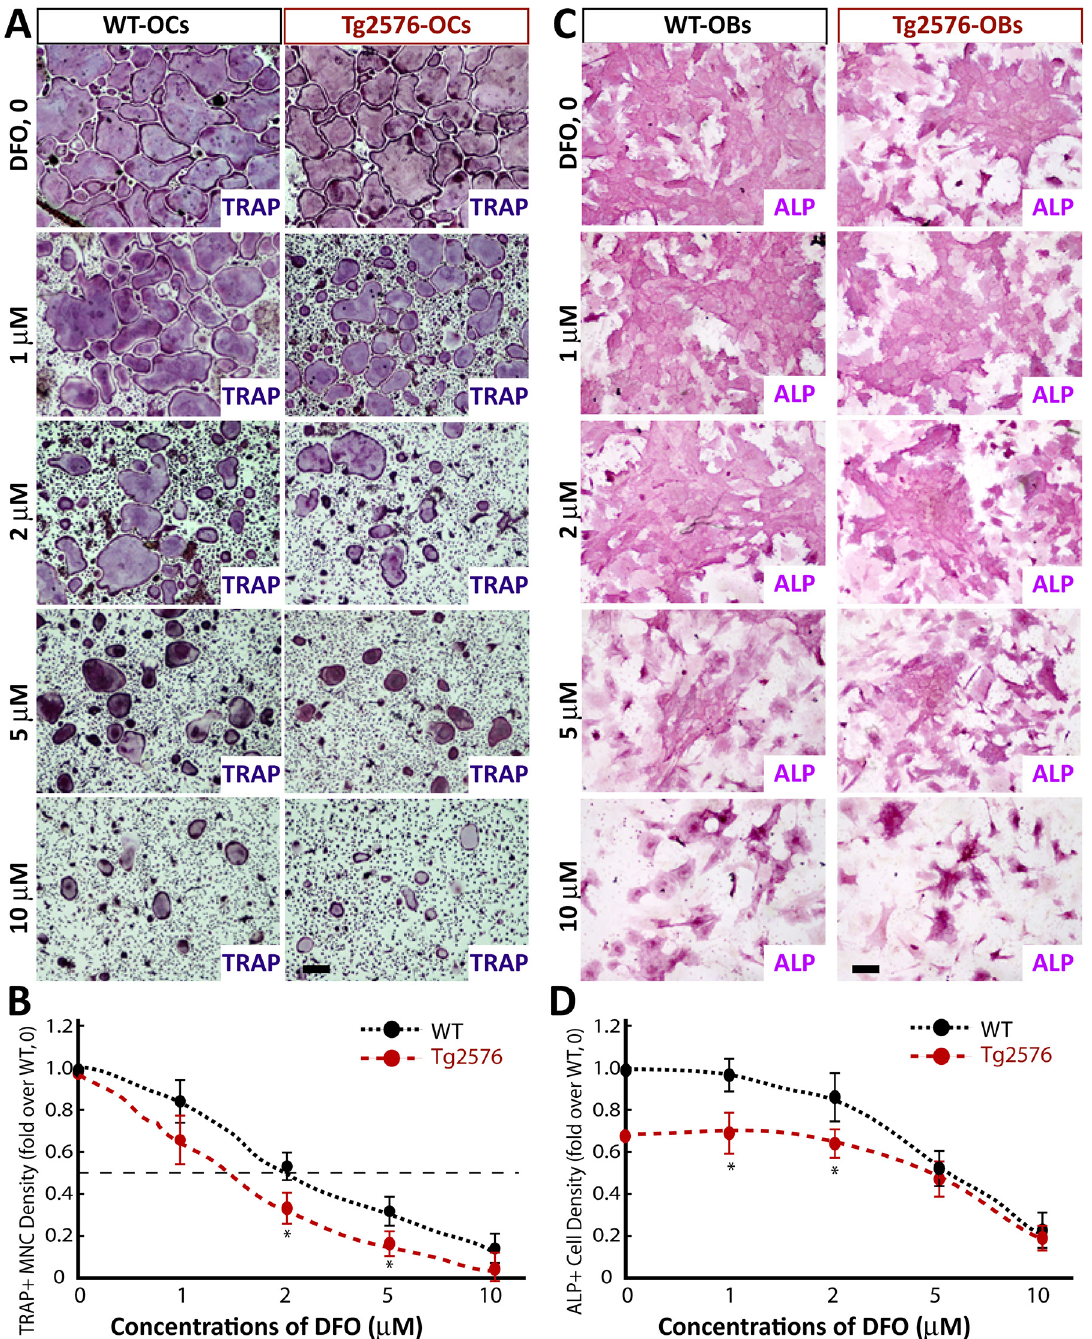
Fig 5. DFO inhibition of in vitro OC genesis in a dose-dependent manner. (A-B) BMMs from WT and Tg2576 mice were induced for OC differentiation in the presence or absence of various concentrations (0, 1-, 2-, and 5- μ M) of DFO. At day 5 of RANKL induction, cells were stained for TRAP. A, Representative images. B, quantitative analyses. The effective concentrations of DFO for 50% inhibition of OC genesis is ~2- μ M and ~1.5 microM in WT- and Tg2576-BMMs, respectively. (C-D) BMSCs from WT and Tg2576 mice were induced for OB differentiation in the presence of various concentrations of DFO. At day 7, cells were stained for ALP as described in the Methods. C, Representative images. D, Quantitative analyses. The values of mean ± SD from 3 separate cultures were shown.